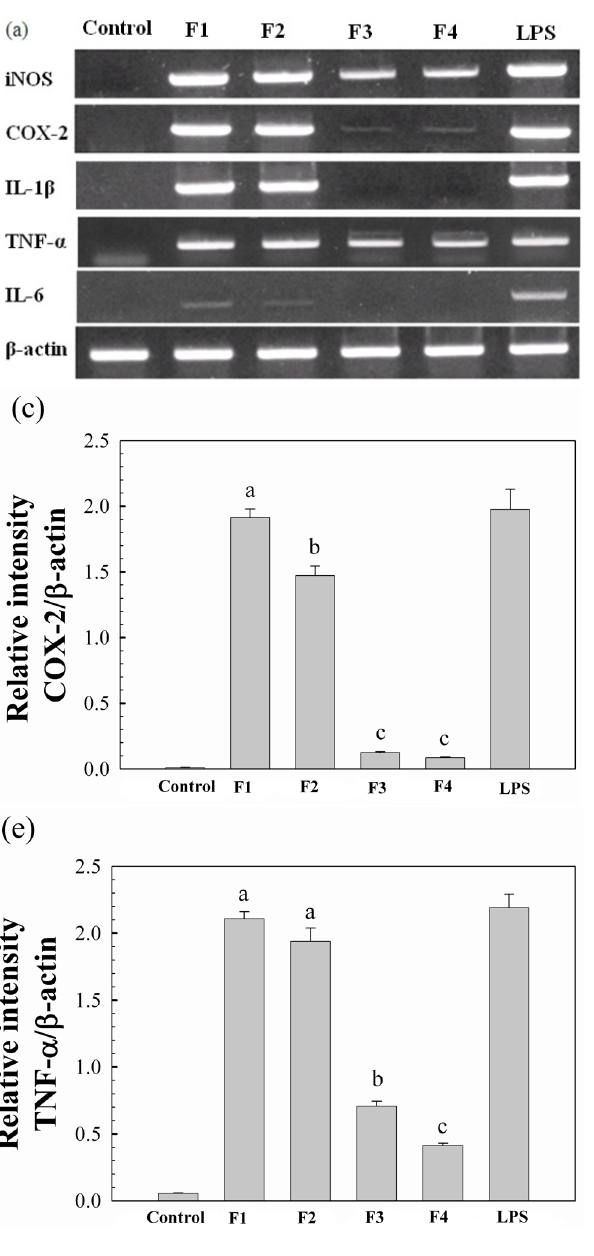
Figure 4. The effects of the water-unextractable proteoglycans (F1, F2, F3 and F4) on iNOS, COX-2, IL-1β, TNF-α and IL-6 expression in Raw264.7 cells. ( a ) Representative PCR gels stained with ethidium bromide. Cells were incubated with LPS (1 μg/mL) and proteoglycans (12 μg/mL) for 18 h. Total RNA was isolated, and mRNA expression was determined by RT-PCR; Graphic analysis of the PCR product for RNA levels of iNOS ( b ), COX-2 ( c ), IL-1β ( d ), TNF-α ( e ) and IL-6 ( f ). All data are presented as the mean ± standard deviation (n =